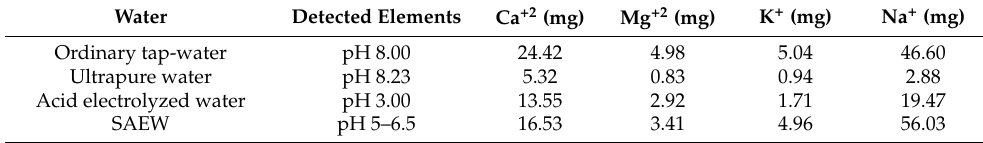
Table 1. pH and concentration of different minerals in water from different